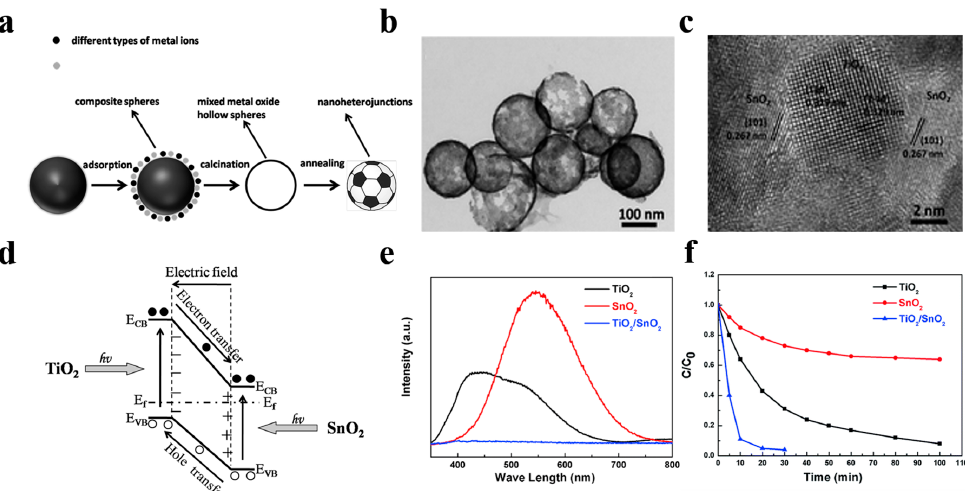
Figure 13. ( a ) Schematic illustration of the formation path of nanoheterostructured photocatalysts. ( b ) TEM image of the TiO 2 /SnO 2 hybrid nanostructure. ( c ) HRTEM images of the TiO 2 /SnO 2 nanoheterojunctions. ( d ) Schematic illustration of band structure of TiO 2 /SnO 2 heterojuction. ( e ) The PL spectra of three different hollow spheres, red line for SnO 2 , black line for TiO 2 , and blue line for TiO 2 /SnO 2 . ( f ) The photocatalytic activity measurement of different structures towards RhB under full light irradiation. Reproduced with permission from [86]. Copyright Royal Society of Chemistry, 2014.